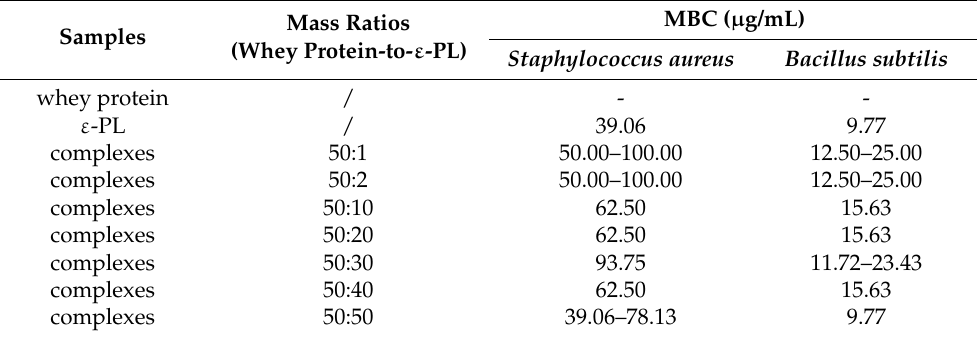
Table 4. The minimum bactericidal concentration (MBC) of whey protein, ε -PL, and whey protein- ε - PL complexes against Staphylococcus aureus and Bacillus subtilis